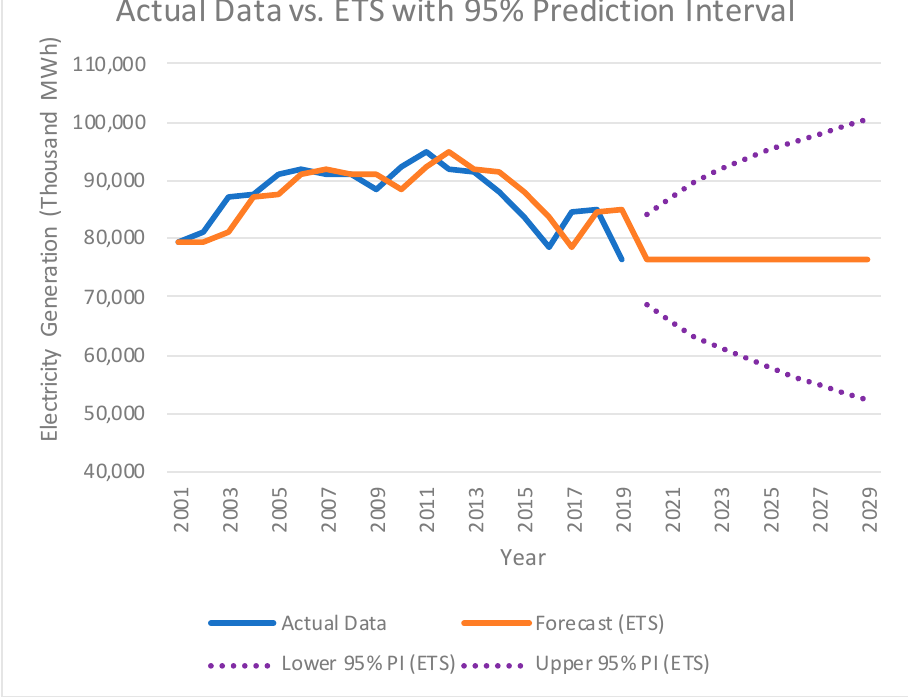
Figure 4. Actual Data vs. exponential triple smoothing (ETS) with 95% Prediction Interval.